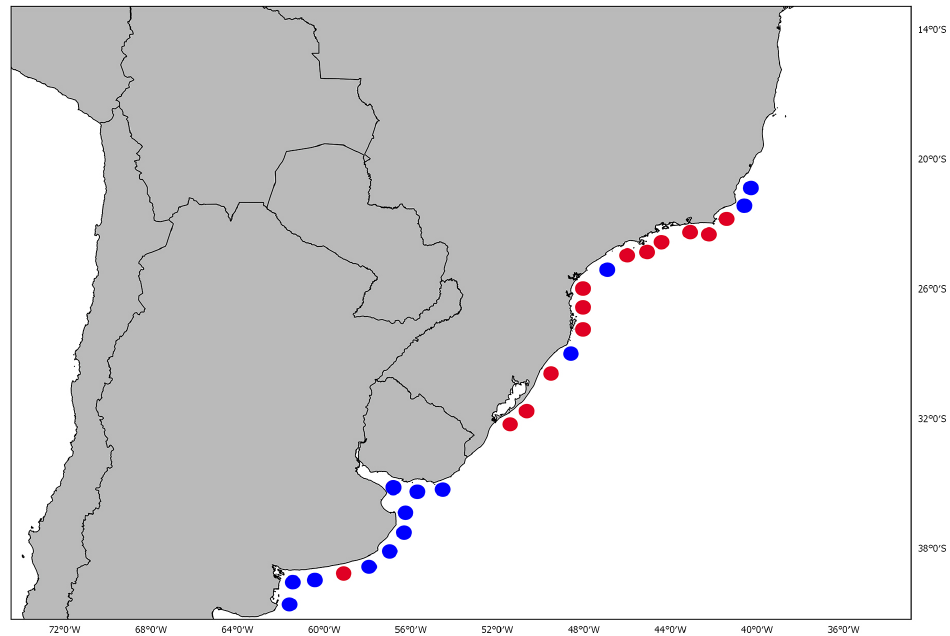
FIGURE 9 | Map showing the geographic distribution of Rioraja agassizii based on material examined in this study (red) and literature